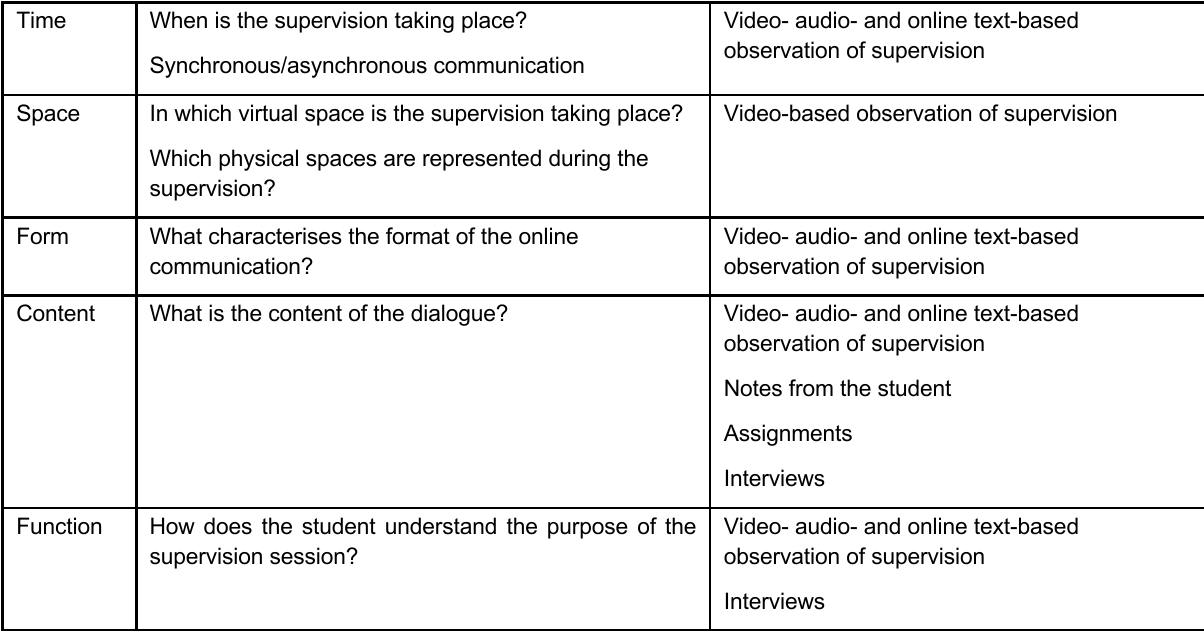
Table 3: Illustration of the research categories and data used for the study